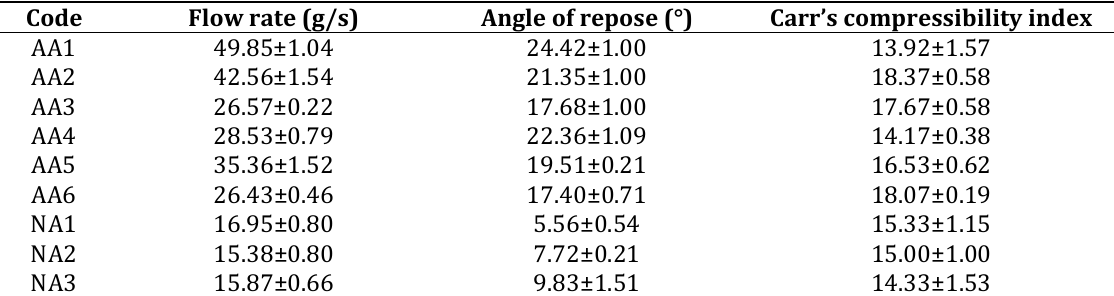
Table II. Flow properties of atorvastatin calcium liquisolid system Code